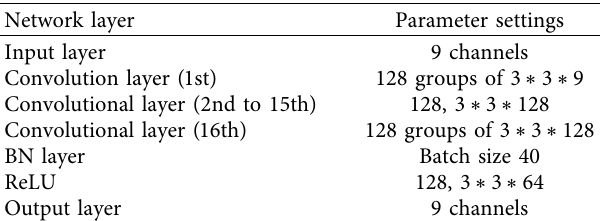
Figure 2: Schematic diagram of the network training process of the value chain e-commerce model. Table 1: Value chain e-commerce mode network framework pa- rameter